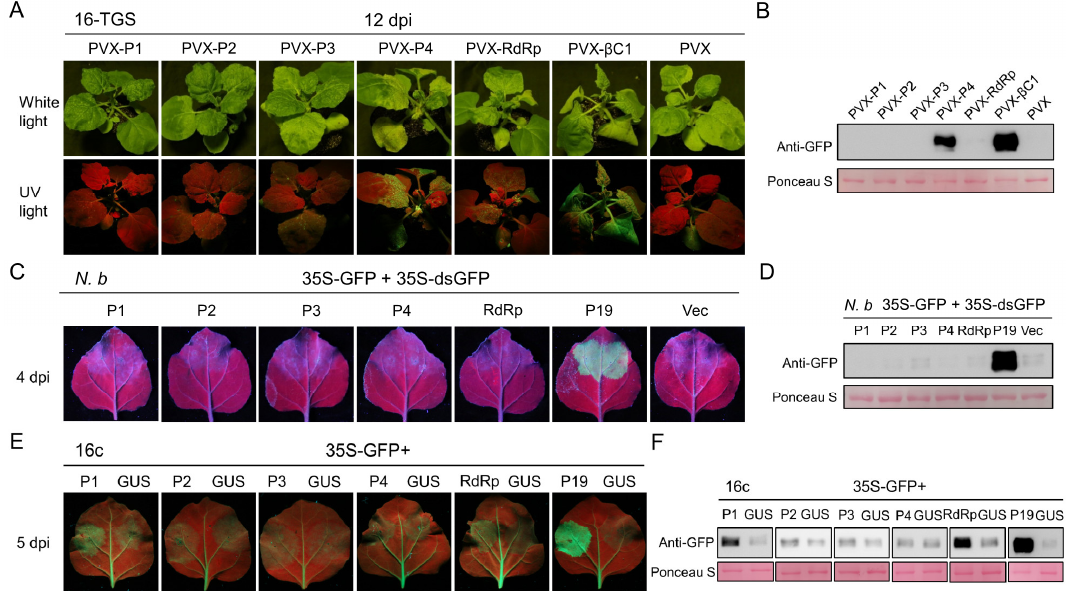
Figure 7. P1, RdRp, and P4 of PSCYV function as a suppressor of RNA silencing. ( A ) Photographs of 16c-TGS N. benthamiana plants inoculated with PVX-P1, PVX-P2, PVX-P3, PVX-P4, PVX-RdRp, PVX-βC1 (the positive control), or PVX (the negative control) under white light or UV light at 12 dpi. ( B ) Western blot assay analyzing GFP accumulation levels in the leaves from ( A ). ( C ) N. benthamiana leaves infiltrated with a mixture of A. tumefaciens expressing GFP (35S-GFP) and double-stranded GFP (35S-dsGFP), and P1, P2, P3, P4, RdRp, P19 (the positive control), or Vec (Vector, the negative control) were photographed under UV light at 4 dpi. ( D ) Western blot assay showing GFP accumulation levels in the leaves from ( C ). ( E ) The leaves of 16c N. benthamiana plants co-infiltrated with A. tumefaciens cultures expressing GFP (35S-GFP) and P1-flag, P2-flag, P3-flag, P4-flag, RdRp-flag, P19 (the positive control), or GUS-flag (the negative control) were photographed under UV light at 5 dpi. ( F ) Western blot assays analyzing GFP accumulation levels in the leaves from ( E ). The large RuBisCO subunit stained by Ponceau S serves as the loading control.